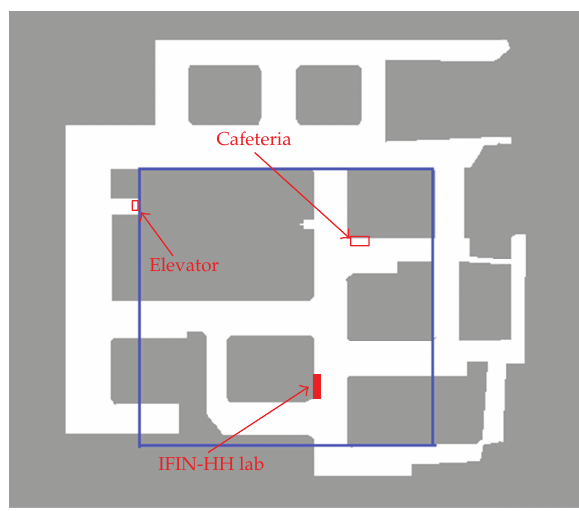
Figure 2: Schematic drawing of UNIREA mine with the low background radiation laboratory, elevator, and cafeteria indicated. The frame represents part of the mine selected for the simulation (cid:3) color online (cid:4)